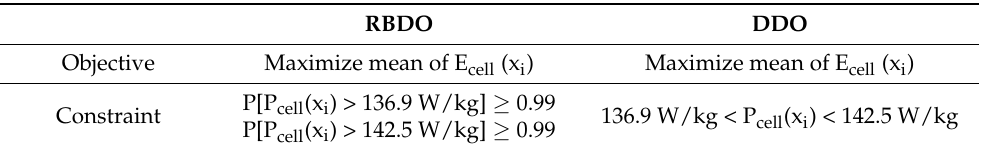
Table 4. Formulation of the reliability-based design optimization (RBDO) and deterministic design optimization (DDO) problems.